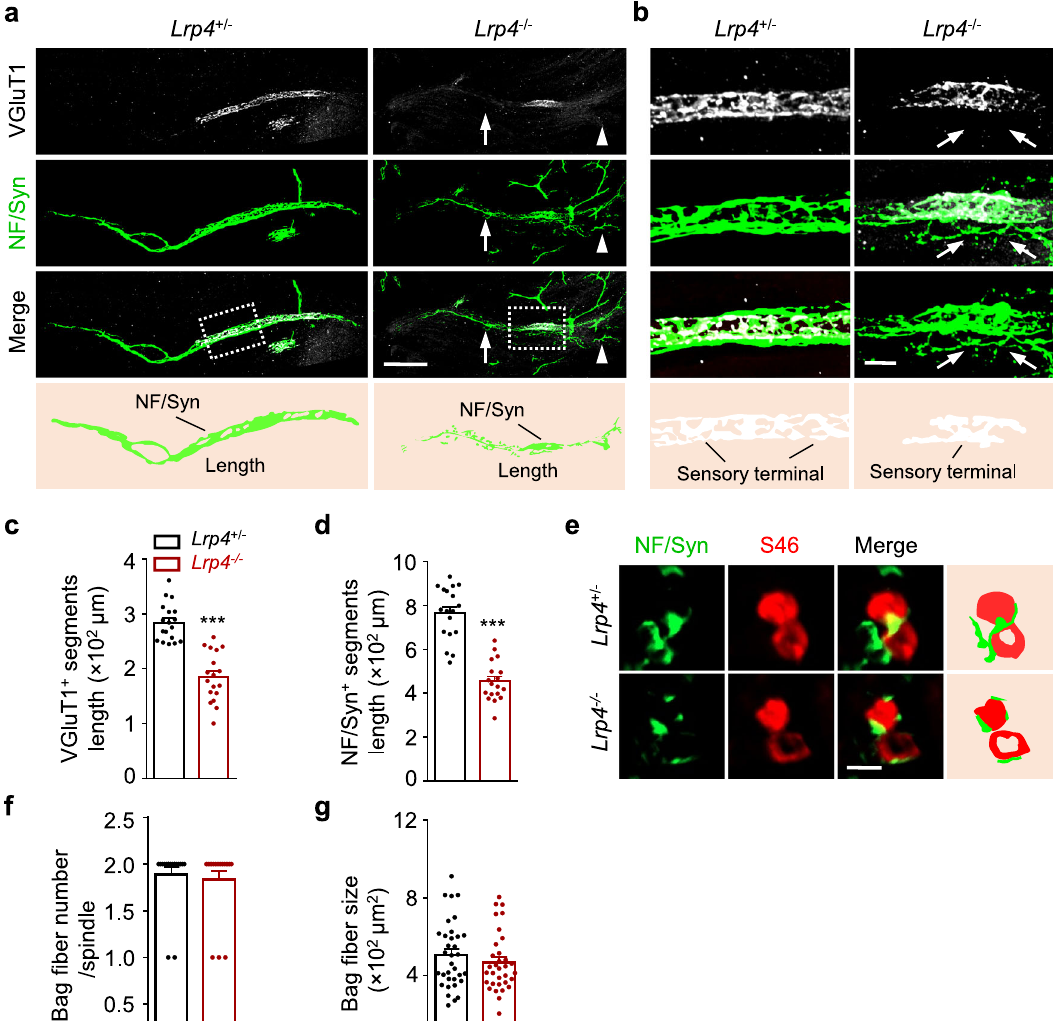
Fig. 2 | A critical role of LRP4 in spindle development at E18.5. a – d Disrupted innervation of intrafusal fi bers in Lrp4 mutant. a Representative images of TA muscle at E18.5 whole mount stained with VGluT1 (gray) and NF/Syn (green). Arrows, poorly organized axon terminals; arrowheads, axon terminal fragments. Scale bar, 100 µ m. b Images enlarged from rectangles in ( a ). Disorganized bound- aries of NF/Syn + segments by Lrp4 knockout. Arrows, axons extended into VGluT1 negativeregion.Scalebar,20 µ m. c , d ReducedVGluT1 + orNF/Syn + segmentslength in Lrp4 − / − . Quanti fi cation of VGluT1 + segments ( t (34) =7.386, *** p <0.0001) or NF/